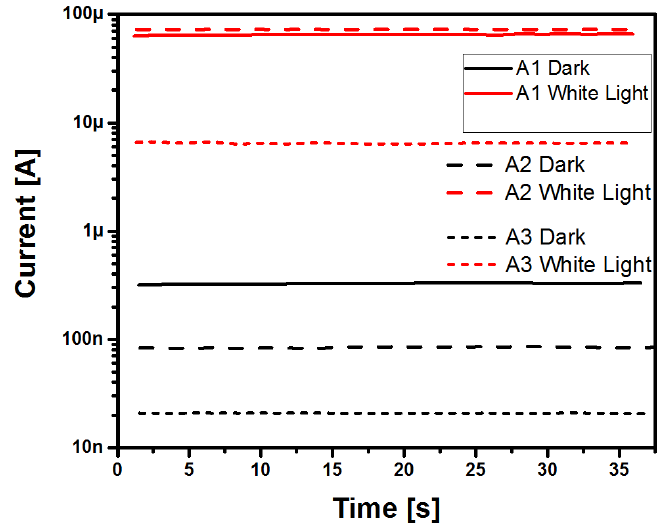
Figure 13. I-t curves of Au/SRO/Si structures with A1, A2, and A3 SRO films under dark and white light illumination.